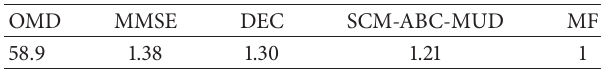
Figure 7: The BER performance with different iteration times of ABC-MUD. Table 2: The comparison of computational complexity using differ- ent MUD